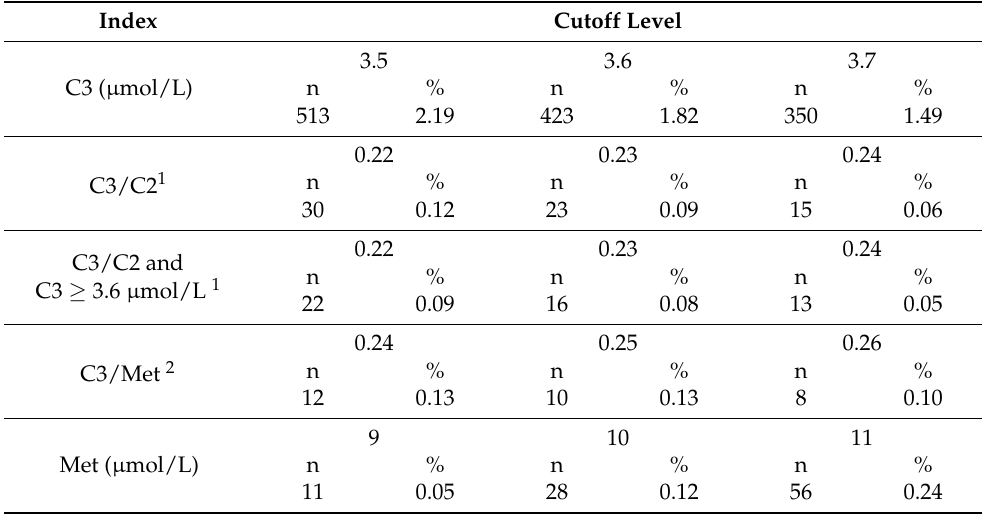
Table 2. Newborns meeting different cutoff levels in the Hiroshima area from April 2016 to March 2017 ( n =